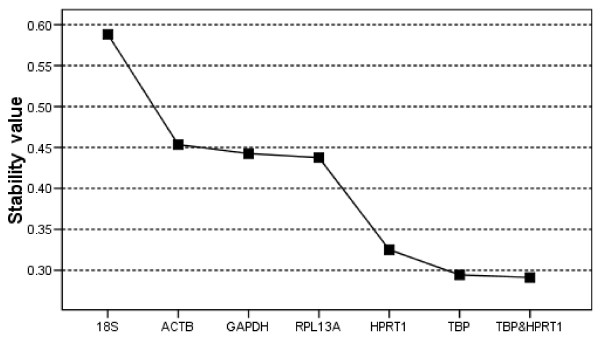
Suitable reference genes for normalization and the best combination calculated by NormFinder program. High expression stability is indicated by a low stability value as an estimate of the intra- and inter-group variation of the individual gene. The X-axis from left to right indicates the ranking of the genes according to their stability values.